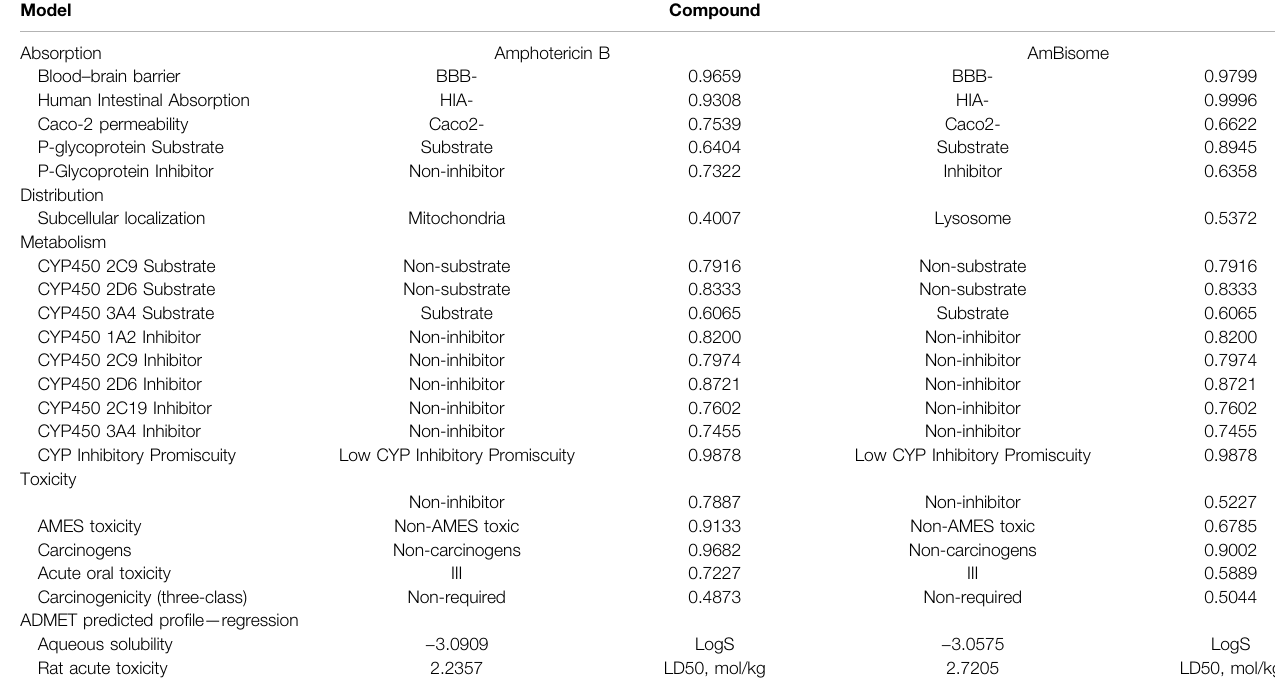
TABLE 4 | ADMET properties of the compounds.